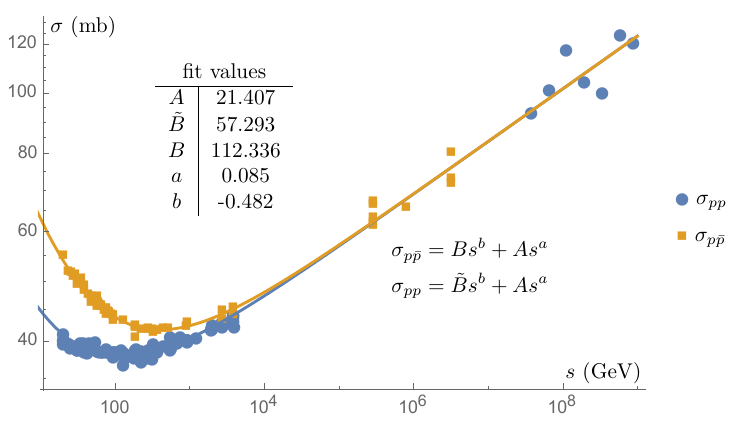
Figure 2 . The total cross sections for proton-proton scattering and proton-antiproton scatter- ing